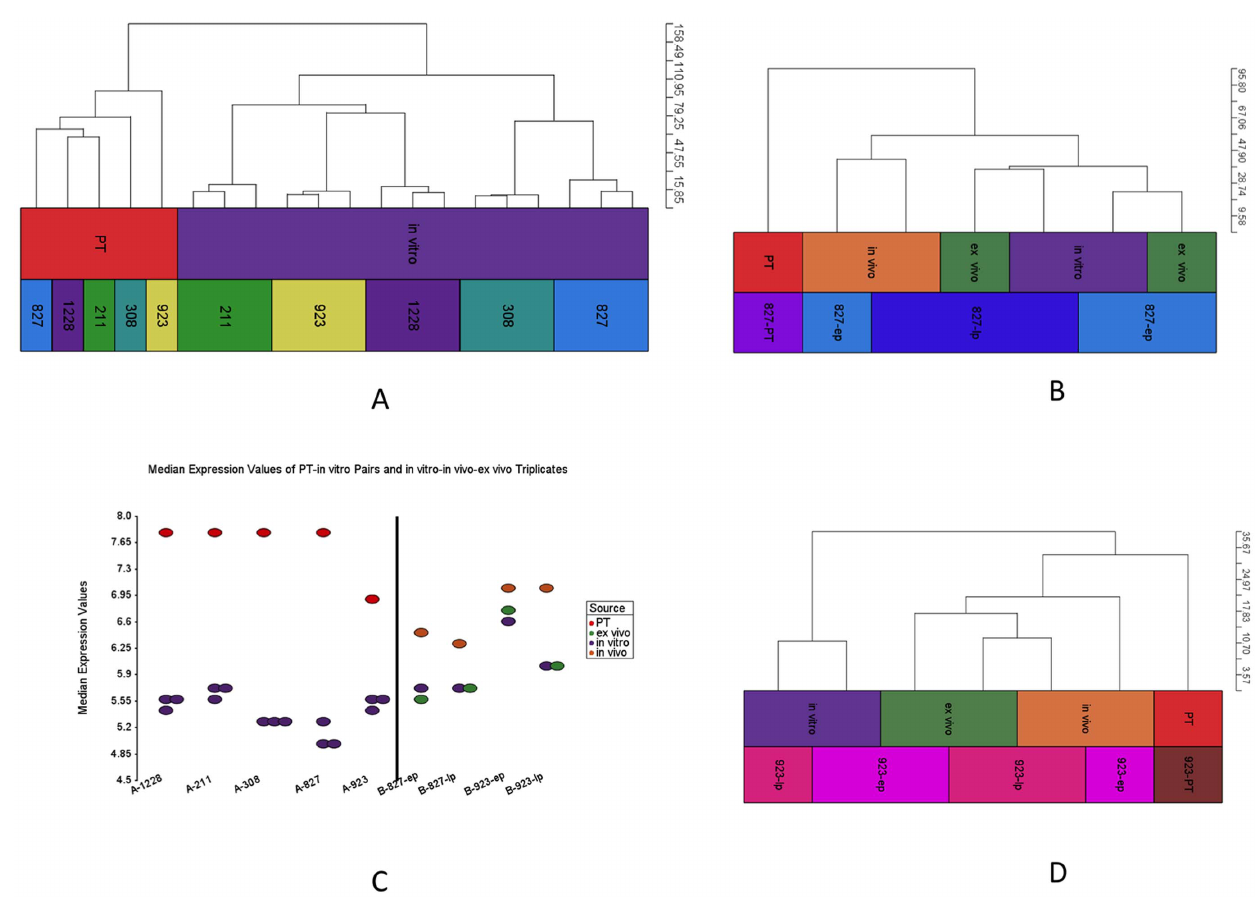
Figure 4. Trancriptome data for high variation (std. dev. . 1.3) 1901 probe sets. (A) HC for matched PT- in vitro pairs for five GSC lines. (B) HC for PT and in vitro-in vivo-ex vivo triplicates for early and late passage 827 samples (C) Median expression values for all samples. (D) HC for PT and in vitro-in vivo-ex vivo triplicates for early and late passage 923 samples.